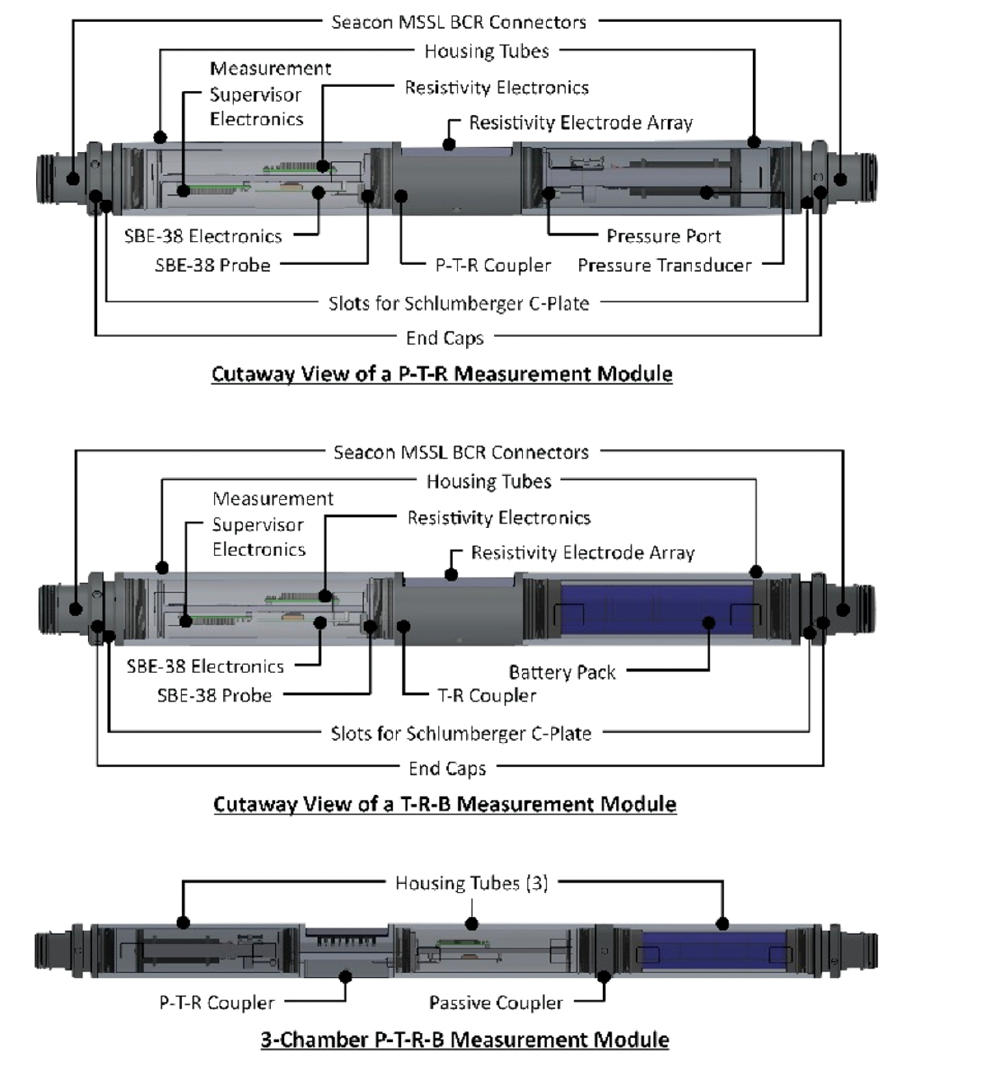
Figure 2. Cutaway view of: PTR (pressure-temperature-resistivity) measurement module (above), TRB (temperature-resistivity-batteries) measurement module (center) and PTRB (pressure-temperature-resistivity-batteries) measurement module